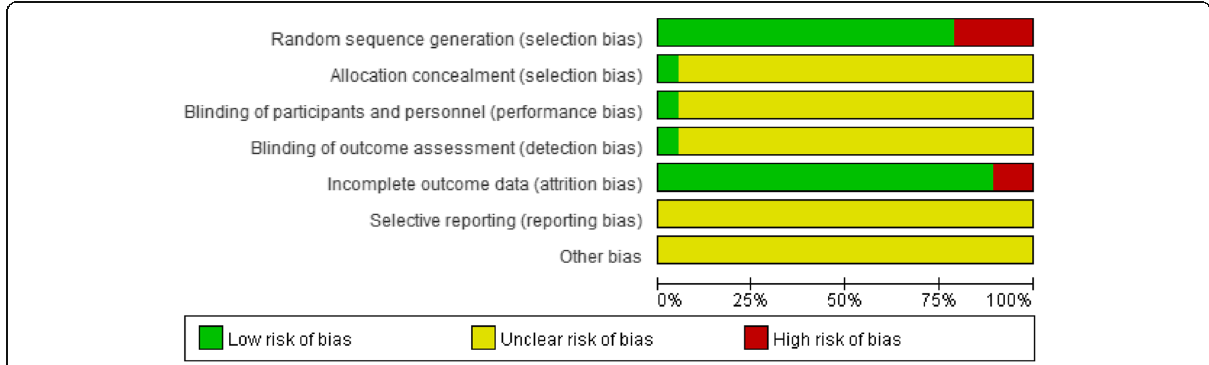
Fig. 7 Risk of bias graph: review authors ’ judgements about each risk of bias item presented as percentages across all included